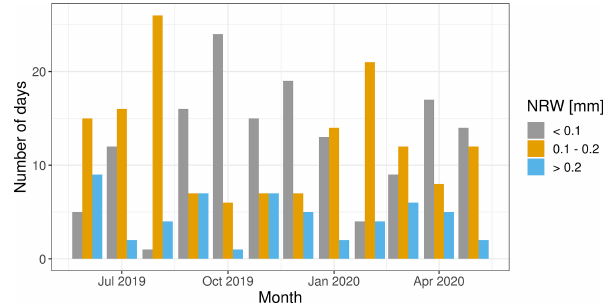
Figure E1. The number of days per month with average NRW in- puts of < 0.1, 0.1–0.2, and > 0 . 2mmd − 1